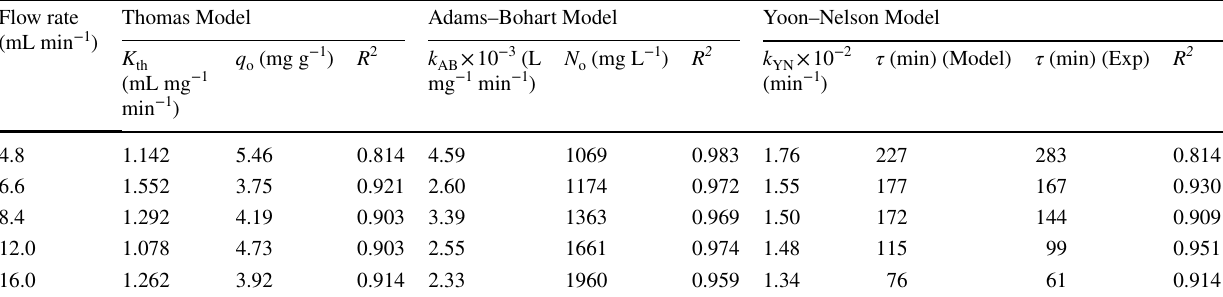
Table 4 Parameters of different dynamic models at different bed